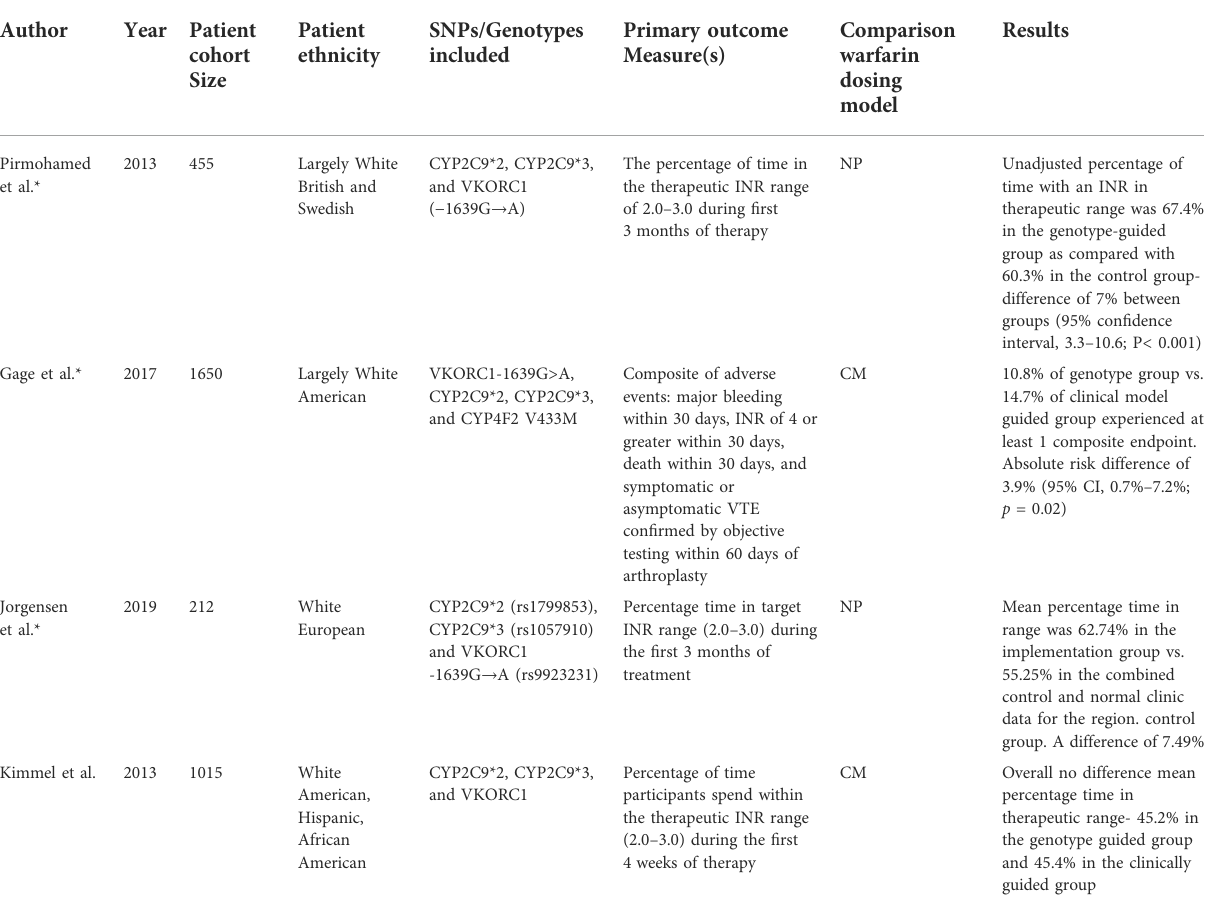
TABLE 1 Compares the polygenic risk score trials in Warfarin